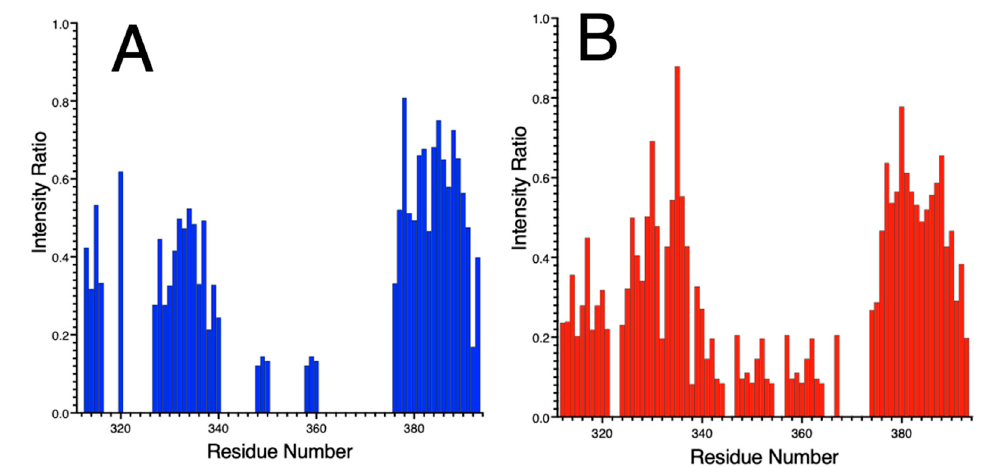
Figure 8. Intensity ratios of the peaks in the ( A ) CON spectrum and ( B ) CACO spectrum obtained at 700 MHz (16.4 T) by 13 C direct detection at pH 7.5 in the absence and presence of 3 eq. Ni(II).